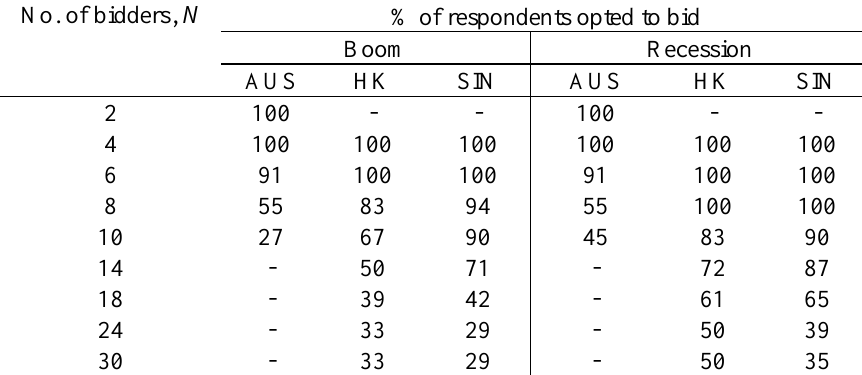
Decision to bid